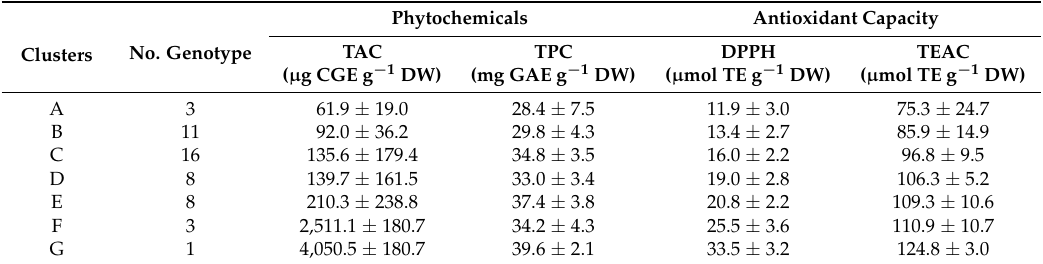
Table 2. Means across two seasons for the total anthocyanin content, total phenolic content and antioxidant capacity in the tassel of seven clusters of waxy corn genotypes.